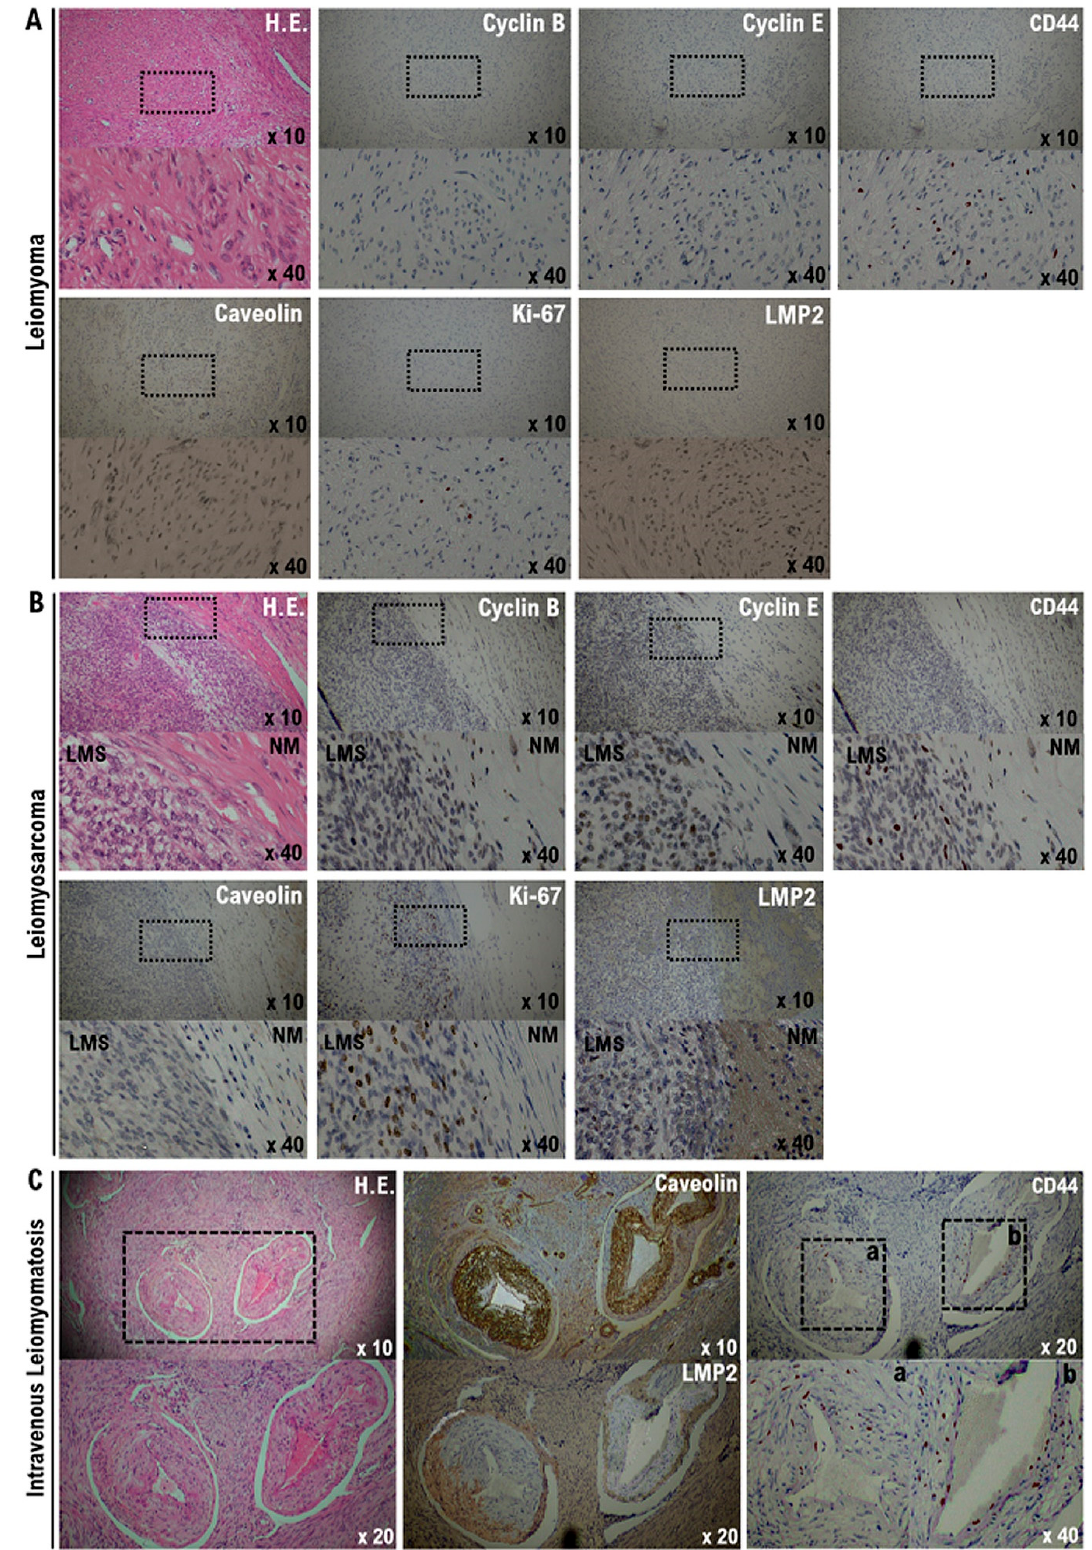
Figure 3. Differential expression of cyclin B, cyclin E, caveolin 1, Ki-67, LMP2/b1i, and CD44 as potential biomarkers in leiomyoma, leiomyosarcoma, and intravenous leiomyomatosis. ( A ) The photograph shows spindle cell leiomyoma. The